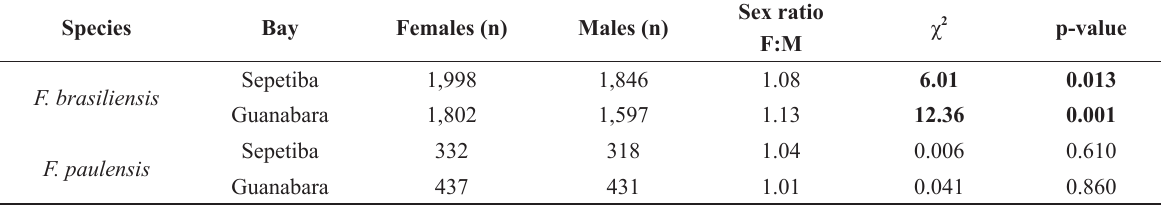
Total abundance and sex ratio for each species ( F. brasiliensis and F. paulensis ) and bay. P-values in bold indicate significant departure from the 1:1 sex ratio (Chi-square test, p < 0.05).